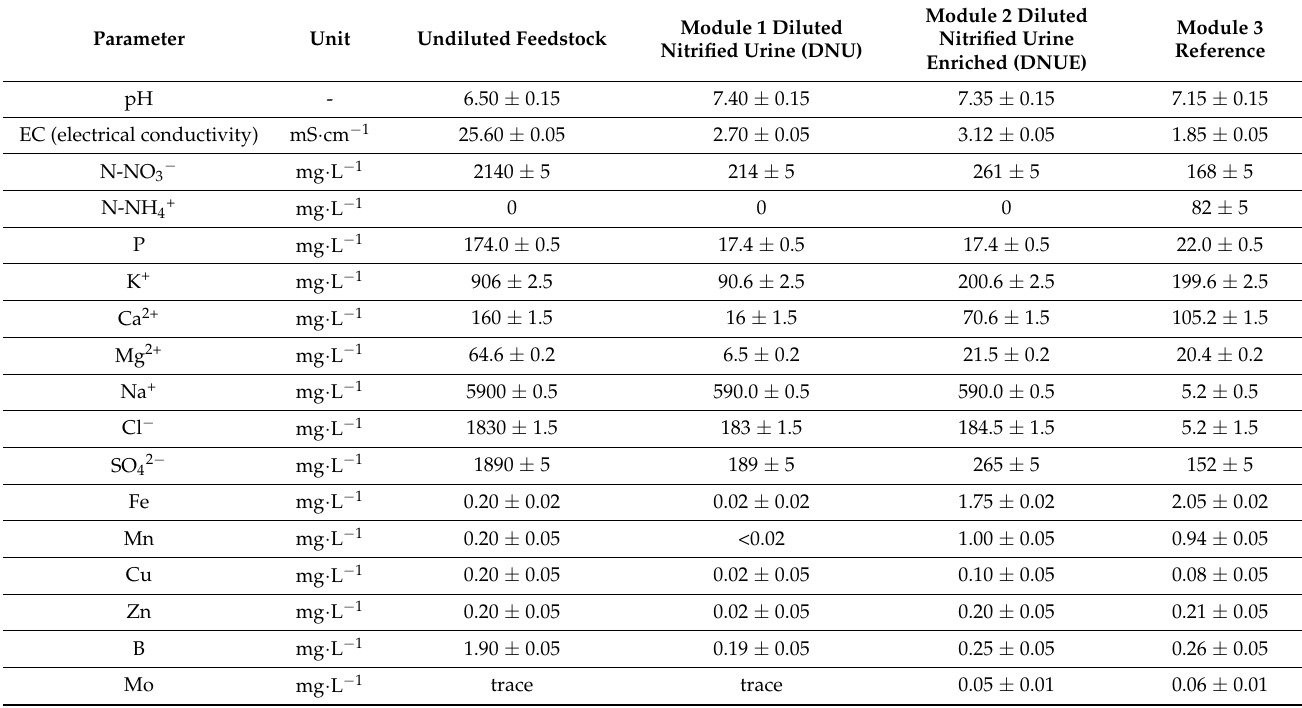
Table 2. Nutrient composition of the feedstock (nitrified synthetic urine) and in the three experimental modules (measured value ± measurement error, N =